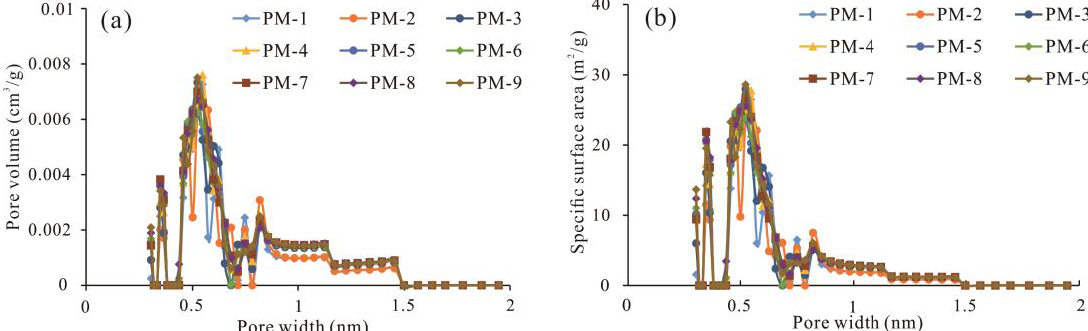
Figure 9. Distributions of the PV and SSA results of different sizes of micropores. ( a ) PV; ( b ) SSA.